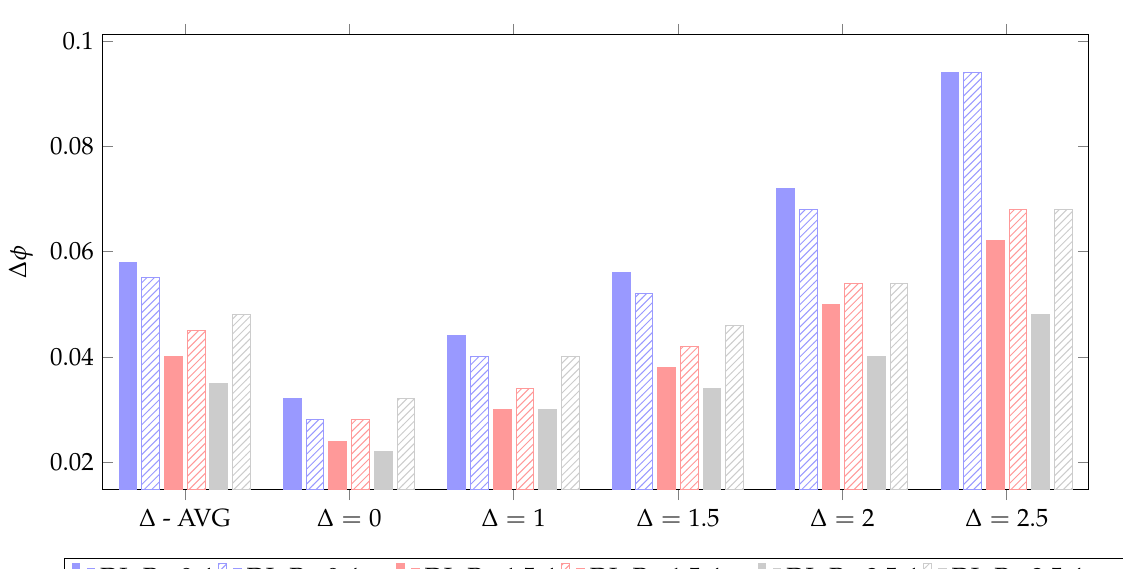
Figure 5. ∆ φ (rad) obtained on HOLODEEP with best model ( D = 4). ∆ -AVG indicates the error averaged on the 25 images, ∆ = X indicates the error averaged on the noisy images obtained with ∆ = X